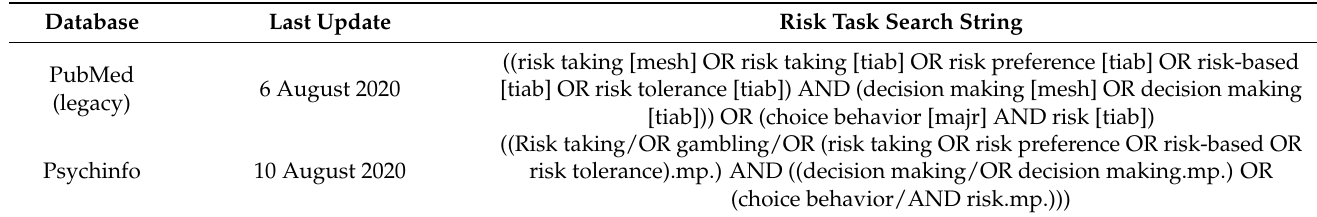
Table 5. Search strings for risk